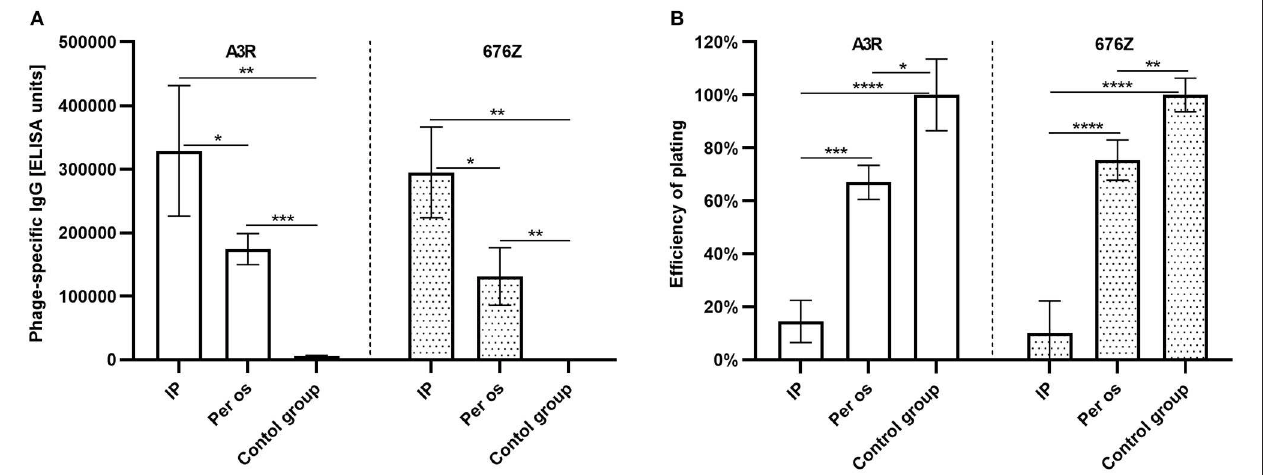
FIGURE 4 | Comparison of A3R and 676Z phage immunogenicity in different administration routes: intraperitoneal (IP) and per os . Intensity of anti-phage IgG induction by A3R and 676Z phages applied per os or intraperitoneally (A) , and efficiency of plating of A3R and 676Z phages with plasma samples from mice treated with A3R or 676Z phage per os and intraperitoneally (B) . Mice ( N = 5, 6, or 7) were administered purified preparations of phages A3R or 676Z in drinking water as a sole water source continuously for 100 days or they were injected with the phages intraperitoneally (IP). For oral treatment a dose of 4 × 10 9 pfu/ml was used, thus making ∼ 2 × 10 10 pfu/mouse daily, 2 × 10 12 in total. Intraperitoneal immunization was done with three successive injections of 1 × 10 10 pfu/mouse on days 0, 20, and 50. Antibody levels were tested in samples collected on day 100. Results were normalized and ELISA units were calculated with regard to a standard curve obtained for reference phage-specific sera (41, 48, 49). EOP was tested for plasma samples collected on day 100 and diluted 2,000-fold. Exemplary results are presented. Statistically significant differences between groups are marked with asterisks: * p < 0.04, ** p < 0.006, *** p ≤ 0.0003, **** p < 0.0001 (one-way ANOVA Brown-Forsythe and Welch test; outliers were